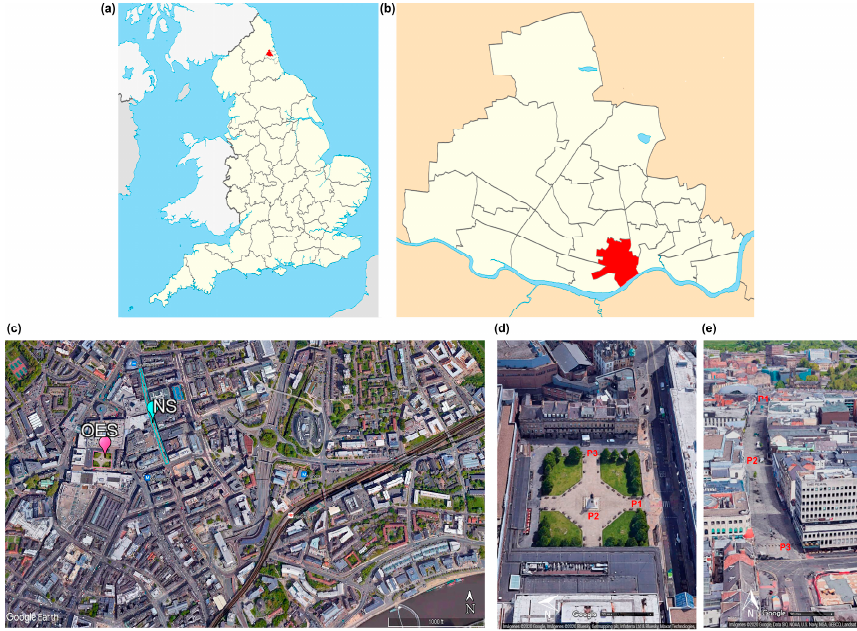
Figure 3. Case study of Newcastle upon Tyne. ( a ) Location of Newcastle in the UK; ( b ) location of Westgate in Newcastle upon Tyne; ( c ) location of Old Eldon Square (OES) and Northumberland Street (NS); ( d ) aerial view of OES and location of measurement points; ( e ) aerial view of NS and location of measurement points.